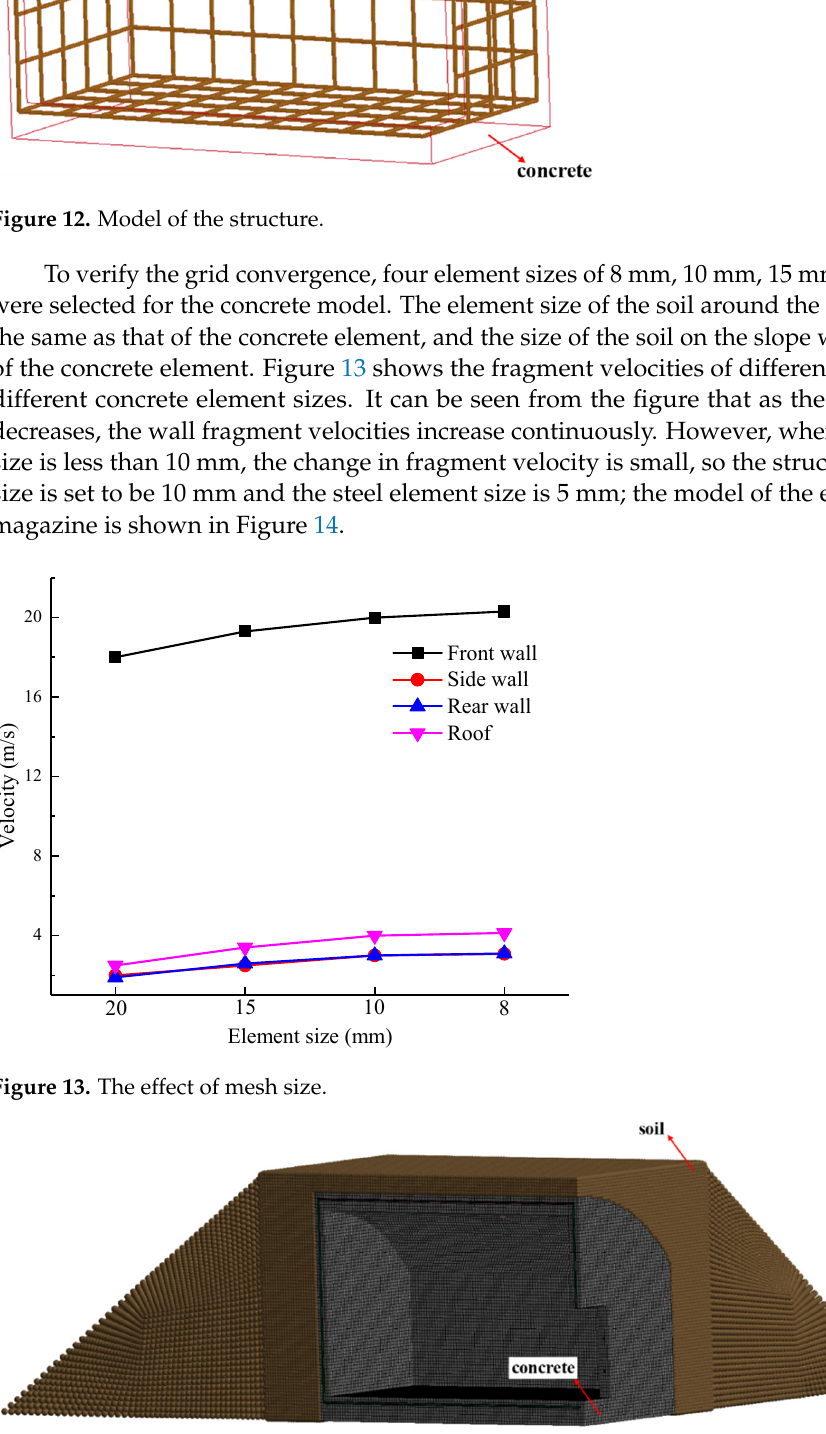
Figure 14. Earth-covered magazine model.